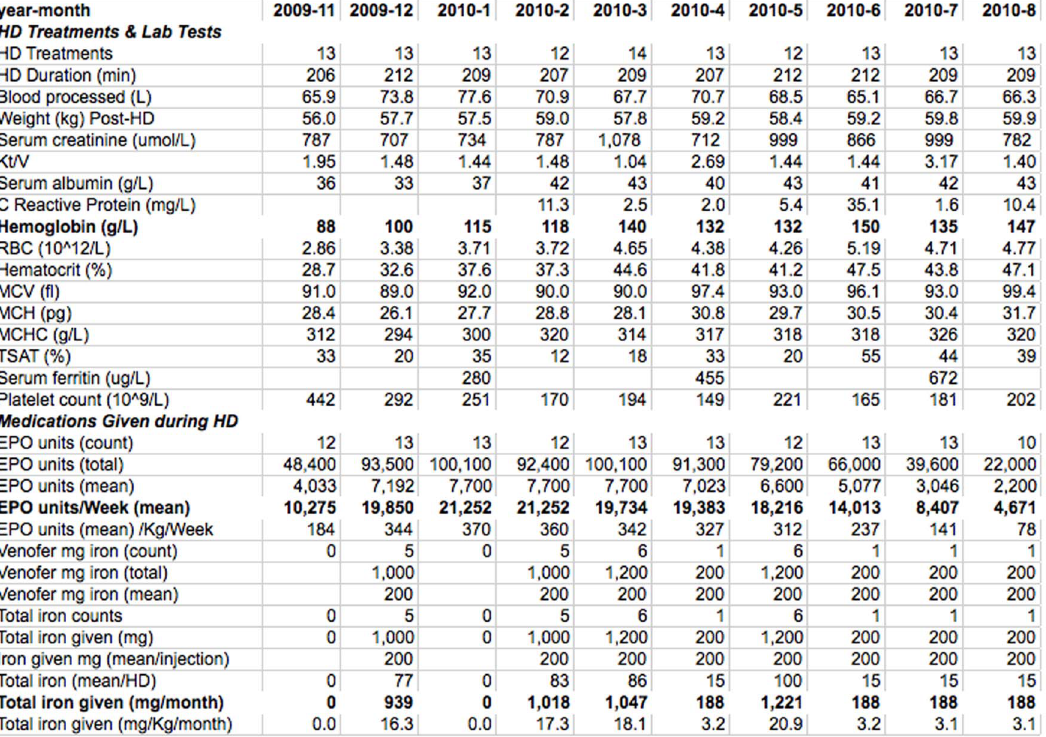
Figure 3. Aggregate report used for CQI in a 44 year old female patient treated by dialysis for 23 years. Although the report was run monthly for the latest 18-months, for clarity only a 10-month time span is shown. This report automatically calculated data for monthly intervals during 2009. Displayed are HD treatments, data relevant to the erythron and iron status, and the EPO and IV iron administered. In November 2009 to January 2010, despite EPO administration of 355–445 units/Kg/week, hemoglobin was low and falling; the low TSAT and relatively low MCH pointed to iron insufficiency. She received 3.4 g of iron intravenously between February and May 2010. An increase in Hb, TSAT, MCH, and serum albumin was evident in May, and continued.